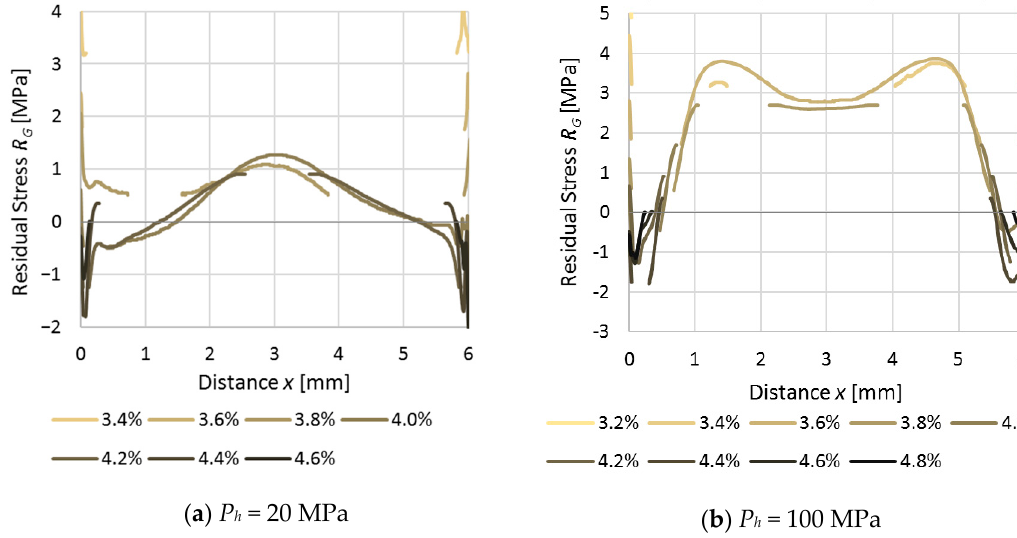
Figure 7. Residual stress calculated from grey scale ( R G ). Samples produced with di ff erent holding pressures: ( a ) 20 MPa and ( b ) 100 MPa.